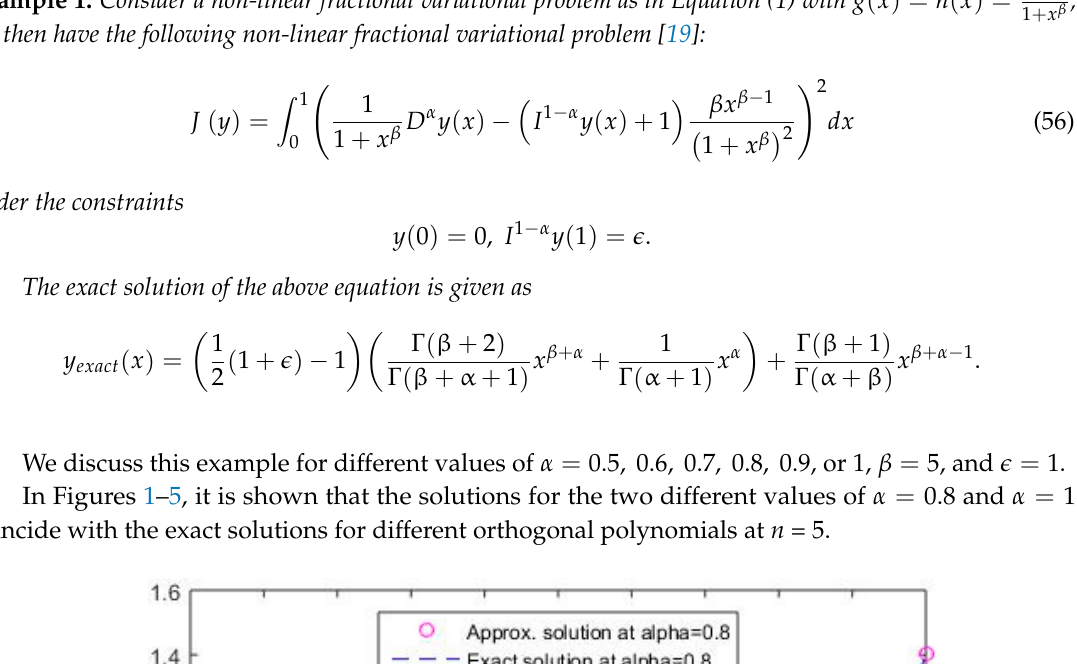
Figure 2. Comparison of exact and numerical solutions using S2 for 𝛼 = 0.8 and 𝛼 = 1 , Example 1.